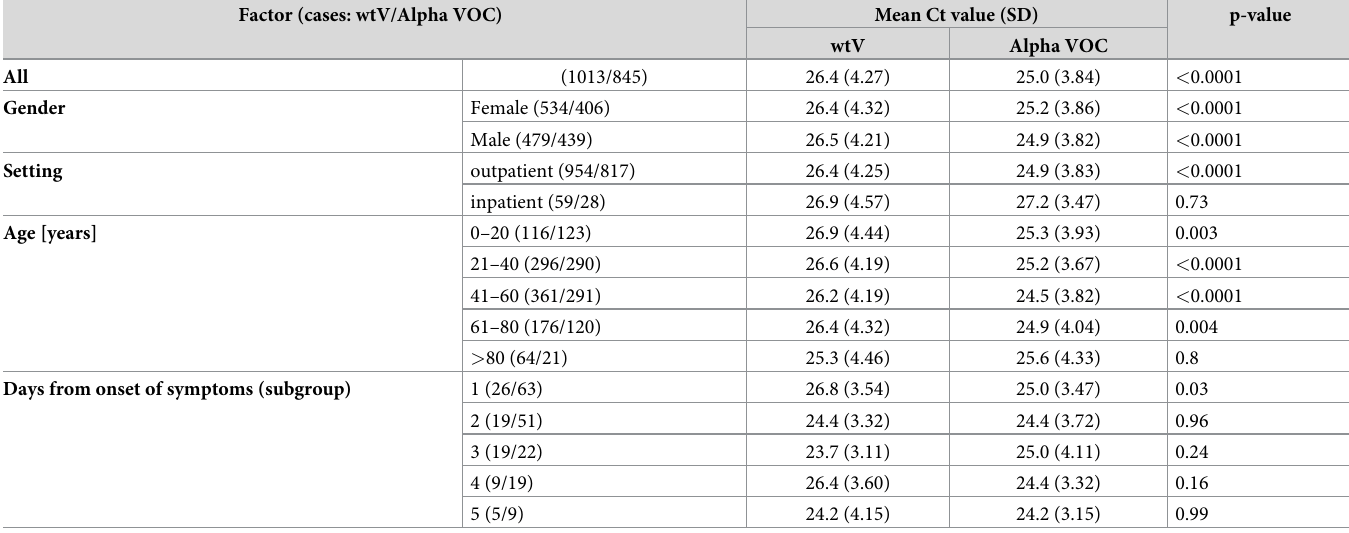
Table 1. Ct values and standard deviations (SD) of wild type SARS-CoV-2 (wtV) and the Alpha variant of concern (VOC) with p-values derived from the associated Mann-Whitney-U tests. Factor (cases: wtV/Alpha VOC) Mean Ct value